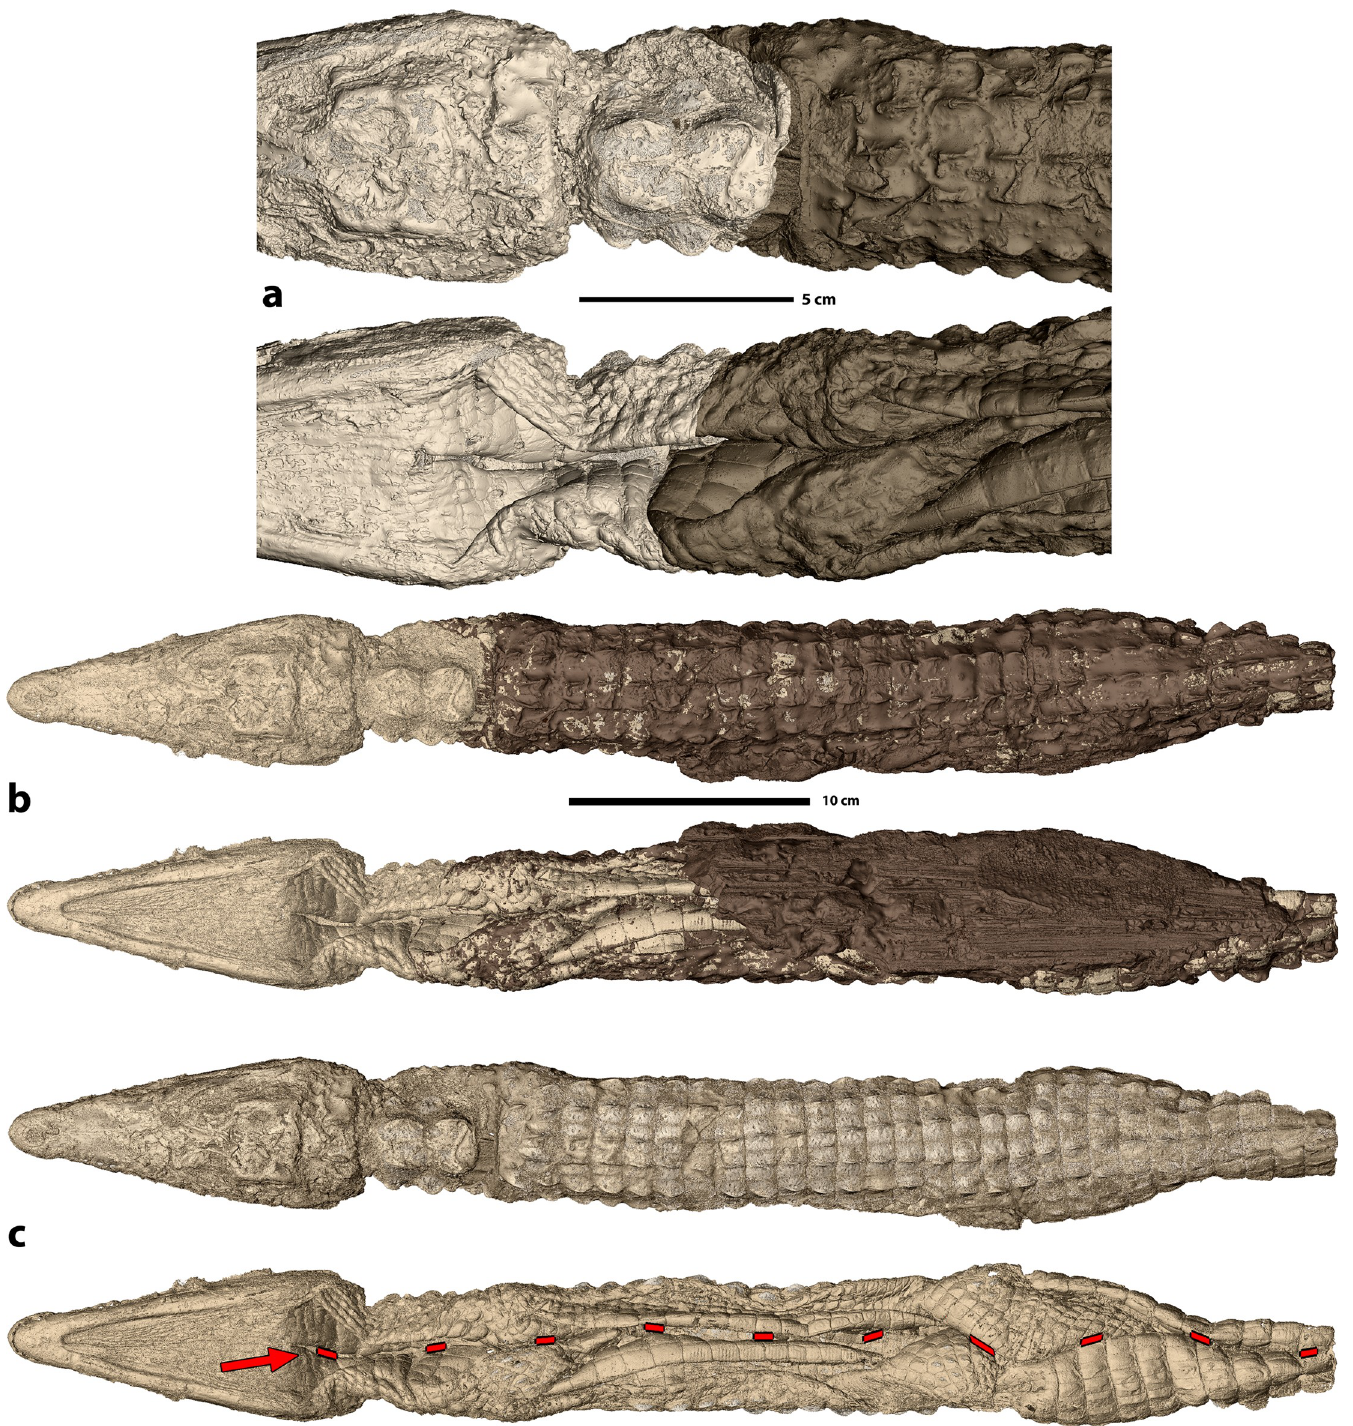
Fig 2. 3D rendering of crocodile mummy MHNL 90001850. a. Nearly perfect 3D match of the two preserved parts of the crocodile in dorsal (top) and ventral (bottom) view. b. 3D rendering of complete specimen with the thick balm in dark brown in dorsal (top) and ventral (bottom) view, c . 3D rendering of complete specimen without balm in dorsal (top) and ventral (bottom) view after removal of the structures overlaying the skin. Ventral view shows the incision used to prepare the body (red arrow and red broken line).